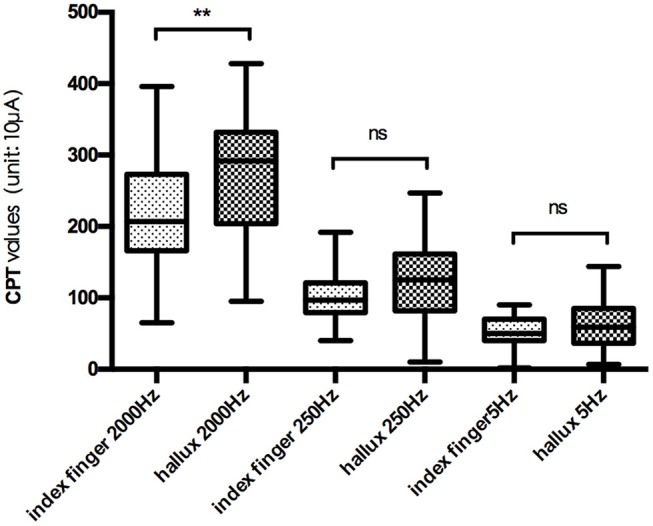
Comparison between CPT values at index finger and hallux. **p < 0.01; ns, no significance.